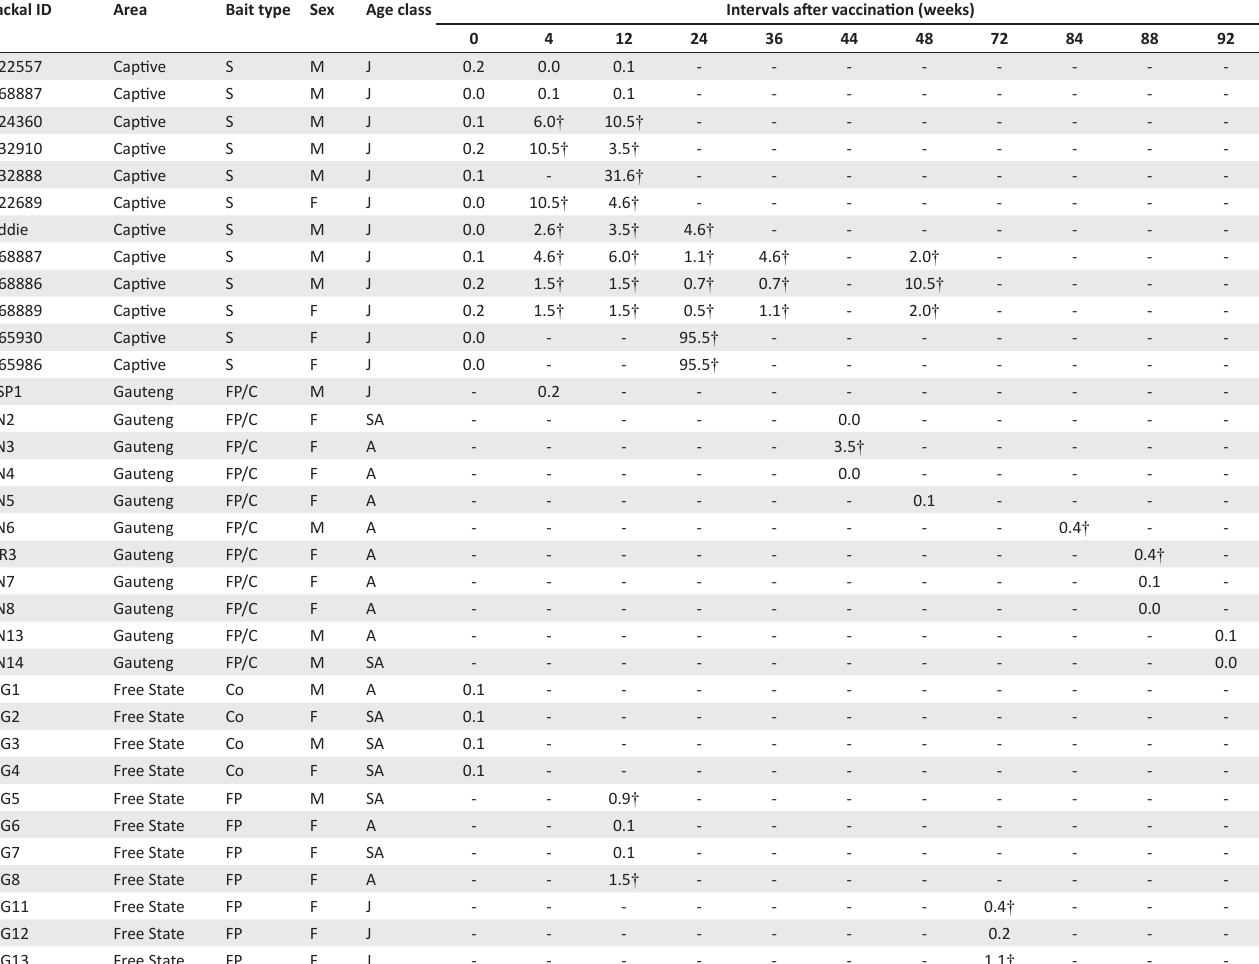
TABLE 1: Rabies antibody titre (IU/mL) of 12 captive and 22 free ranging black-backed jackals in two areas (Gauteng and Free State province) of South Africa after vaccination with Raboral V-RG  vaccine. Jackal ID Area Bait type Sex